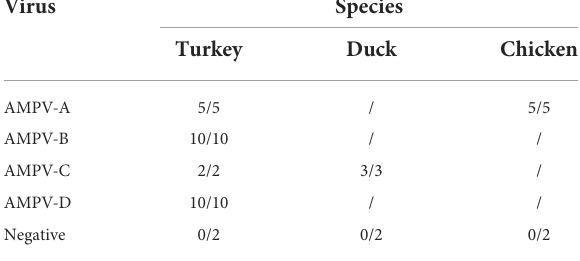
TABLE 4 Detection of AMPV in tracheal swabs from previous experimental trials. Virus